Question: Produce a descriptive caption suitable for publication.
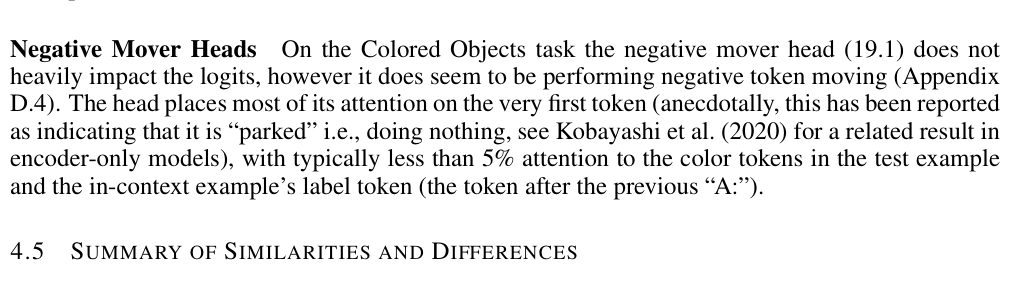
Answer: Left: The full graph of attention heads with the difference of the path patching importance scores between each task (normalized by task per each path patching iteration). Middle: Visualizing only the union of the top 2% most important heads (per path patching stage) for each task, colored by the difference in importance scores. Right: Explanation of each stage of processing in the circuit. Both circuits involve the same general process: detecting a duplication and using that duplication to decide which token to copy. In the Colored Objects task, the duplication is used as a “positive” signal via the content gatherer heads to tell the mover heads which token to copy, while in IOI the duplication sends a “negative” signal via the inhibition heads to tell the mover heads which tokens to ignore. These heads, and the activation of the negative mover head in IOI constitute the only major difference between the two tasks.